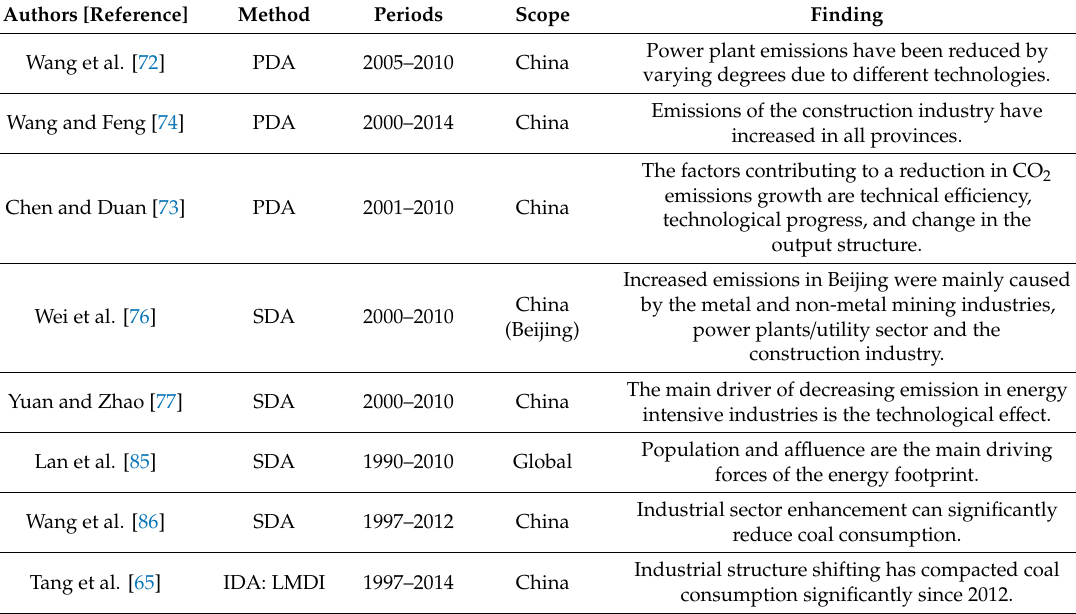
Table 1. Key studies employing the decomposition approach in the energy